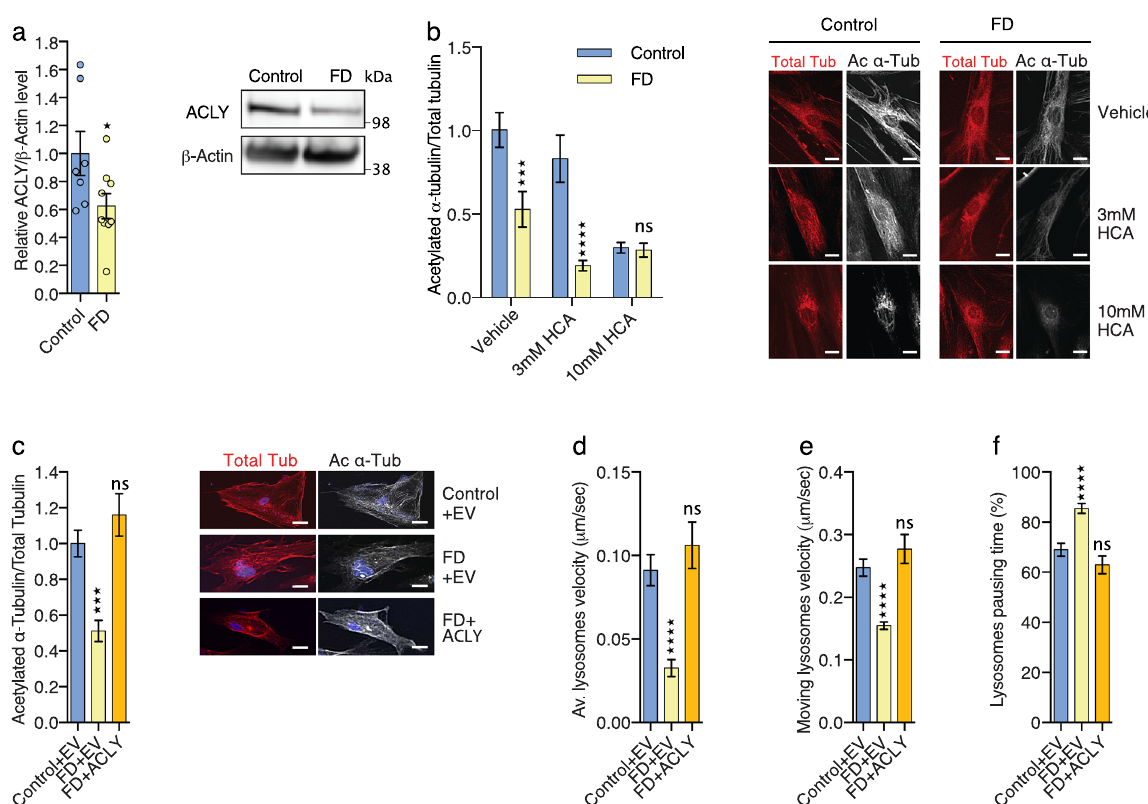
Fig. 4 ACLY expression rescues defects of α -tubulin acetylation and microtubule-dependent transport in human FD fi broblasts. a Immunoblotting of ACLY and ß-ACTIN in cultured human primary fi broblast extracts from Control and FD patients. b Immunolabeling and quanti fi cation of acetylated α - tubulin and total tubulin levels in primary fi broblasts from healthy controls and FD patients incubated with the ACLY inhibitor hydroxy-citrate acid (HCA). Scale bar is 50 µ m. c Immunolabeling and quanti fi cation of acetylated α -tubulin and total α -tubulin levels in extracts from primary fi broblasts from healthy controls and FD patients transfected with control or ACLY expressing plasmids. Scale bar is 50 µ m. d – f Time-lapse recording of MT-dependent transport of lysosome (LysoTracker ® ) in fi broblasts from Control or FD patients, transfected with Control or ACLY plasmids, to analyze average (av.) velocity ( d ), moving velocity ( e ) and percentage of pausing time ( f ). Description of graphical summaries here within are histograms of means ± SEM. Signi fi cance was determined by: ( a ) two-sided t test, ( b ) two-sided two-way analysis of variance (ANOVA), ( c ) two-sided ANOVA, and ( d , e , f ) two-sided Kruskal – Wallis one-way ANOVA. Speci fi cally, [( a ) p = 0.0467, t = 2.181, df = 14; ( b ) p = 0.0038, F interaction (2, 109) = 5.876; ( c ) p < 0.0001, F = 13.17; ( d ) p < 0.0001, K = 48.95; ( e ) p < 0.0001, K = 35.10; ( f ) p < 0.0001, K = 40.98. In addition, the post hoc multiple comparisons to analyze statistical difference of each condition compared to control for ( b ) is Sidak ’ s test, for ( c ) is Dunnet ’ s test, for ( d , e , f ) are Dunn ’ s test, and are * p < 0.05, *** p < 0.001, and **** p < 0.0001. a 5 human primary fi broblast lines per group. b Number of cells: Control n = 26 (Vehicle), n = 18 (3 mM HCA), n = 20 (10 mM HCA); FD n = 18